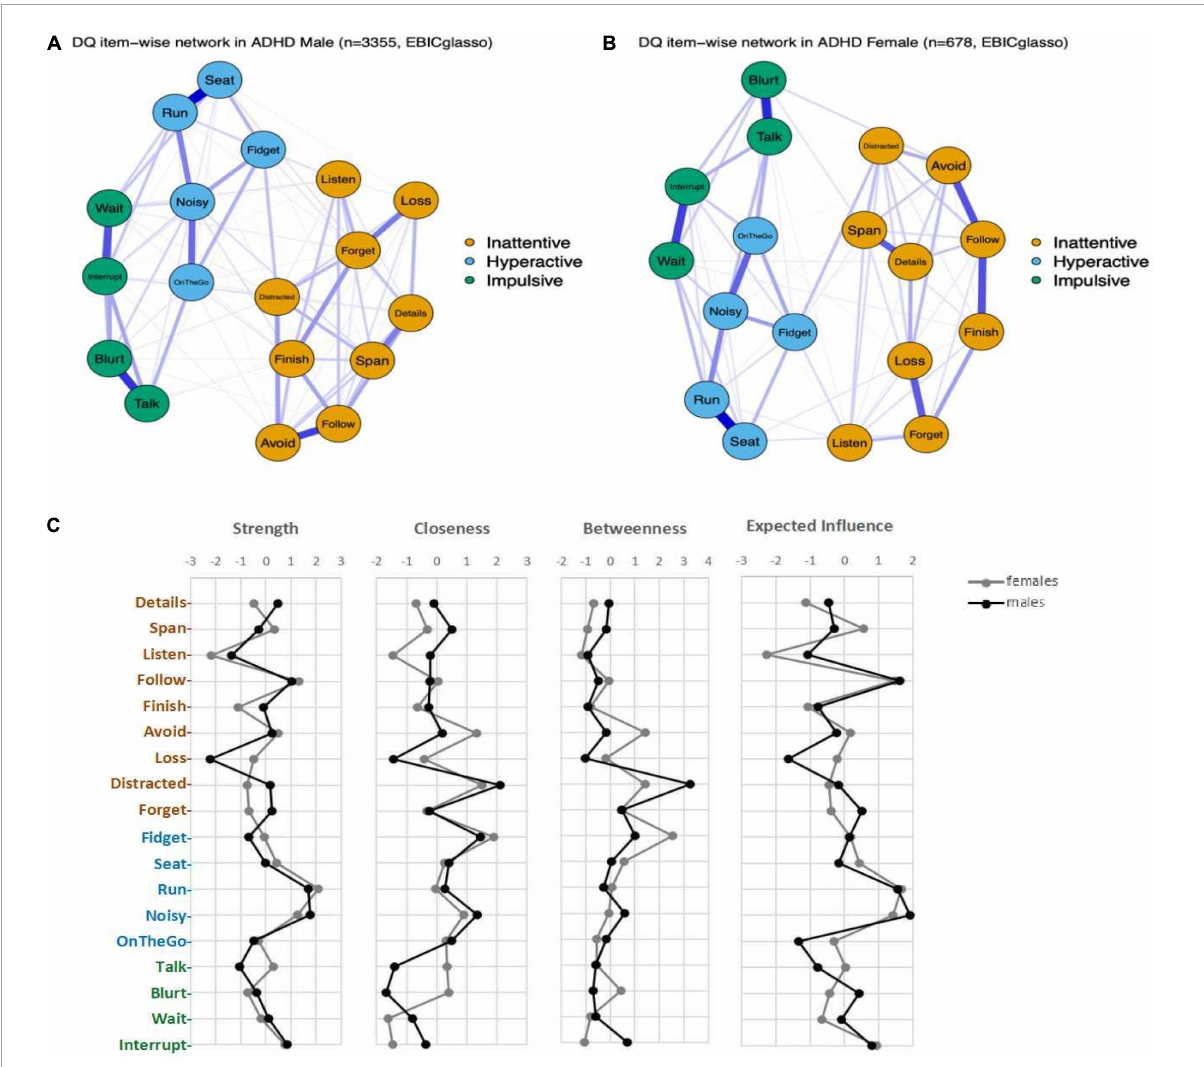
FIGURE4 The network structures in males and females. (A) network in males with ADHD; (B) network in females with ADHD; (C) Centrality indices and Expected Influence of the symptom networks in males and